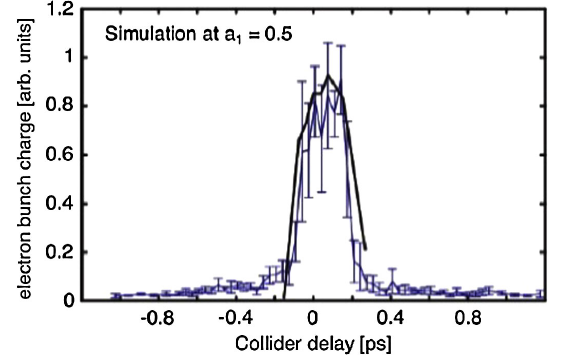
FIG. 6. Charge as a function of delay between the two colliding pulses for the experiments (blue) and the simulations (black). The experiments were operating with a 0 ∼ 3 and a 1 ∼ 0 . 5 [22].